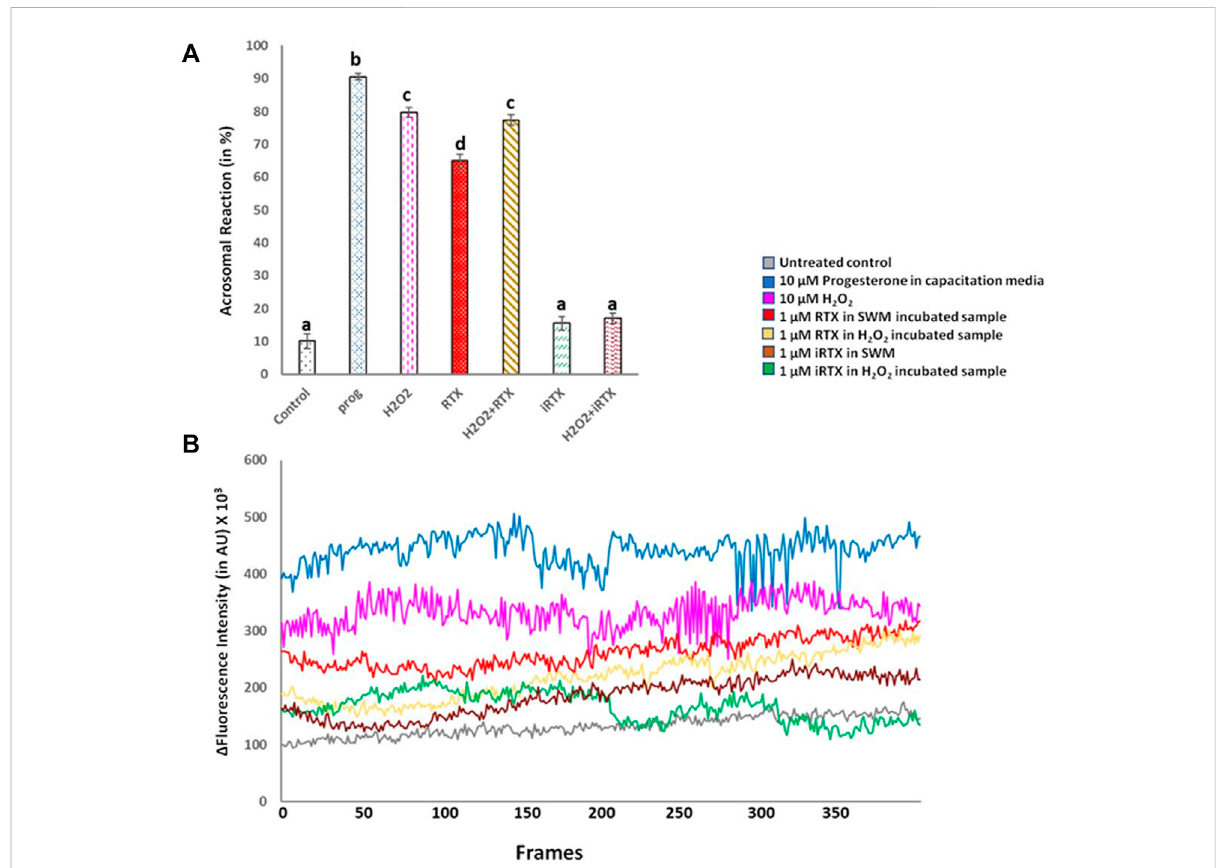
FIGURE 9 Effectofactivation(byRTX)andinhibition(byiRTX)ofTRPV1onoxidativelystressed(H 2 O 2 -treated)spermatozoa,ascomparedtoprogesterone (prog) treated and untreated control (cnt) samples. (A) Bar graph comparing the percentage of spermatozoa with reacted acrosome for different treatment groups; data having superscripts of different letters are signi fi cantly different from each other. (B) Line graph showing the fl uorescence intensities of [Ca 2+ ]I concentrations (measured in arbitrary unit represented in %) at different frames of time-series imaging for different treatment groups, and the time difference between each frame is 5 s and frames 0 – 300 are shown